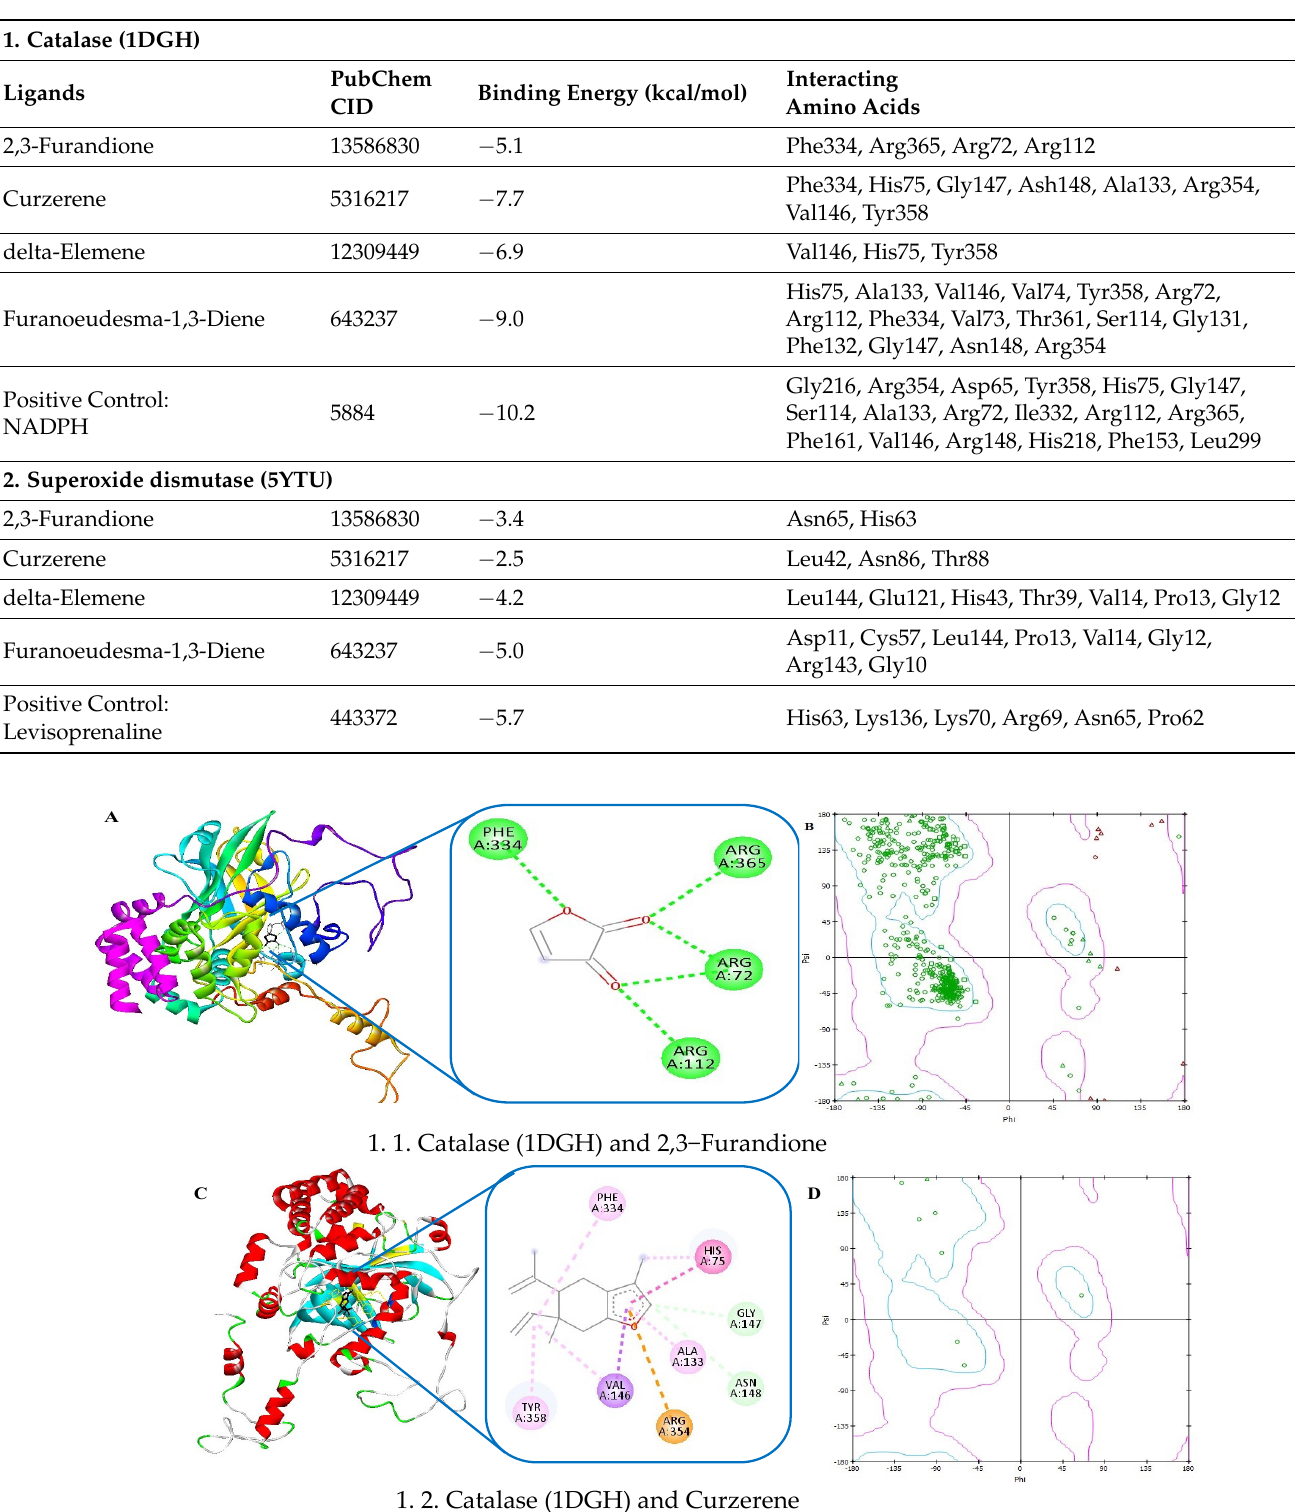
Table 2. Specifications of docking investigations; the ligands, interacting functional residues (amino acids), and corresponding binding energy.